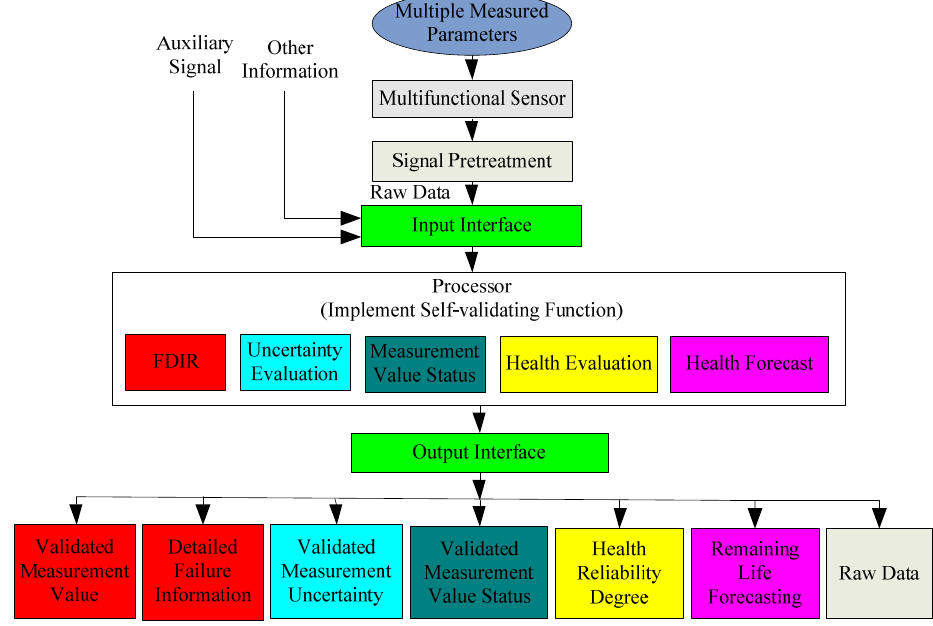
Figure 1. Functional architecture of a multifunctional self-validating